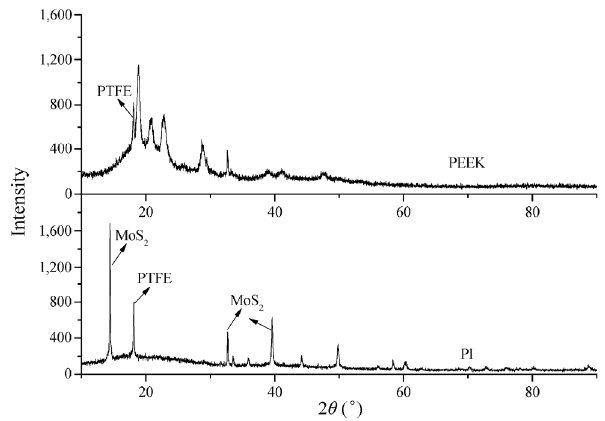
Fig. 16 Typical XRD spectrum of PEEK and PI materials after